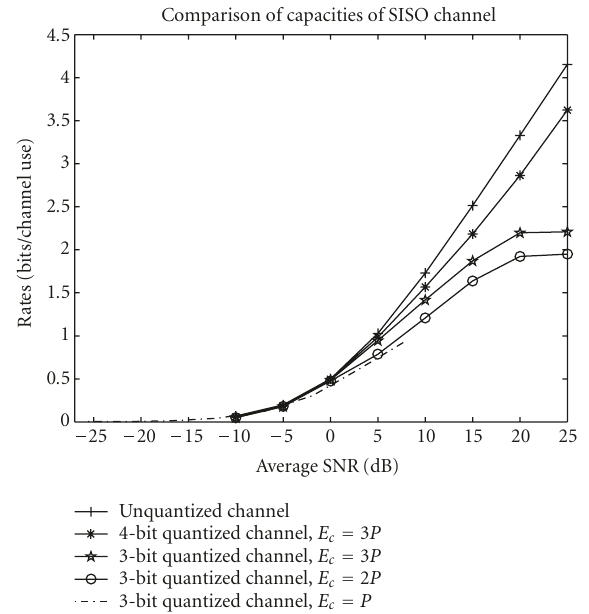
Table 1: Accuracy of predicted value of capacity as SNR